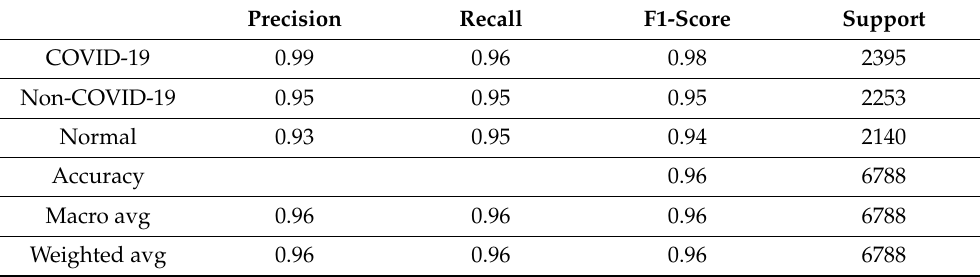
Table 4. Resnet101 Evaluation